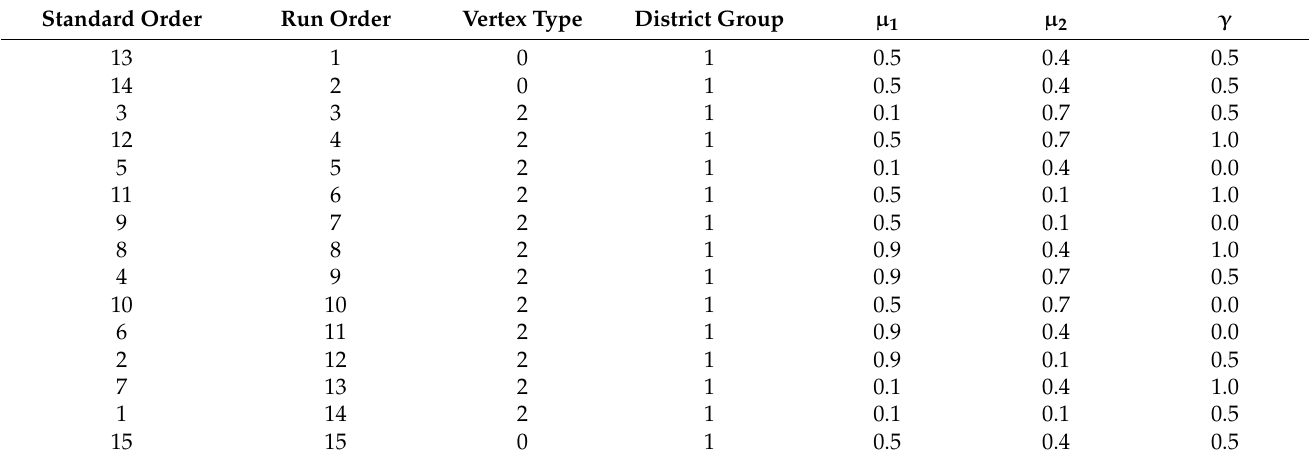
Table 4. Box–Behnken design.